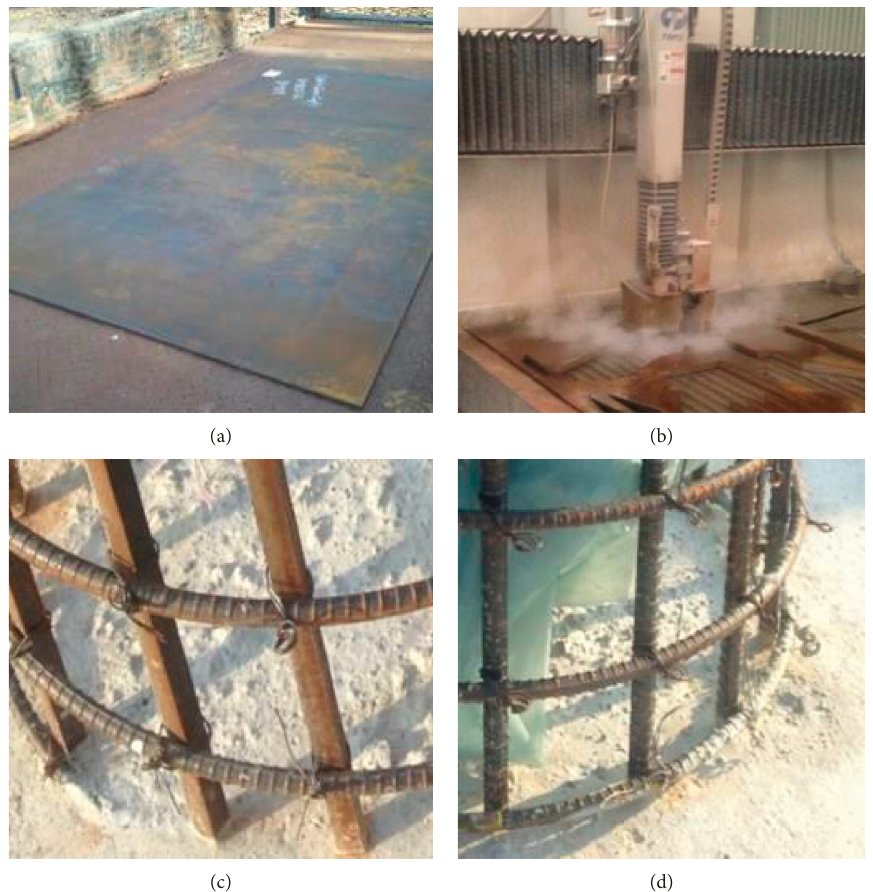
Figure 3: The process of fabricating HMSBs and rebar assembly for an RC pier connection: (a) HMS plate; (b) water-jet cutting; (c) rebar assembly (T-HMSB); and (d) rebar assembly